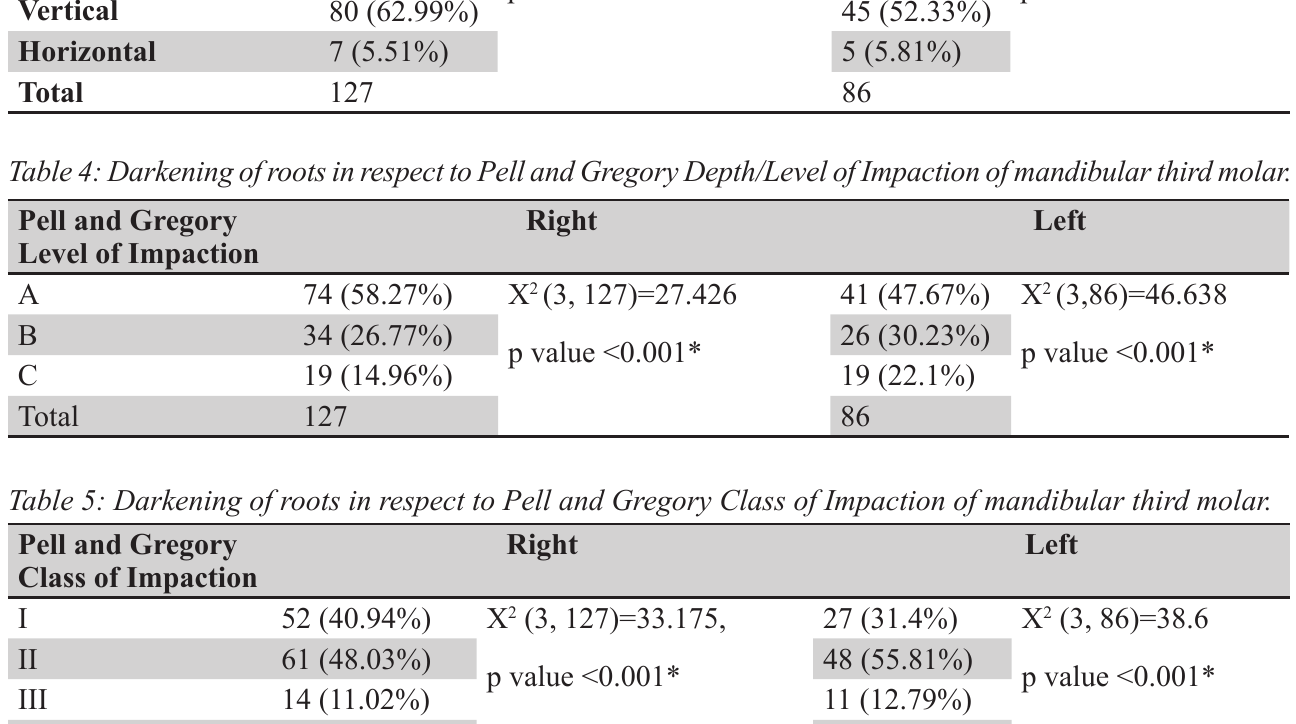
Vertical Horizontal